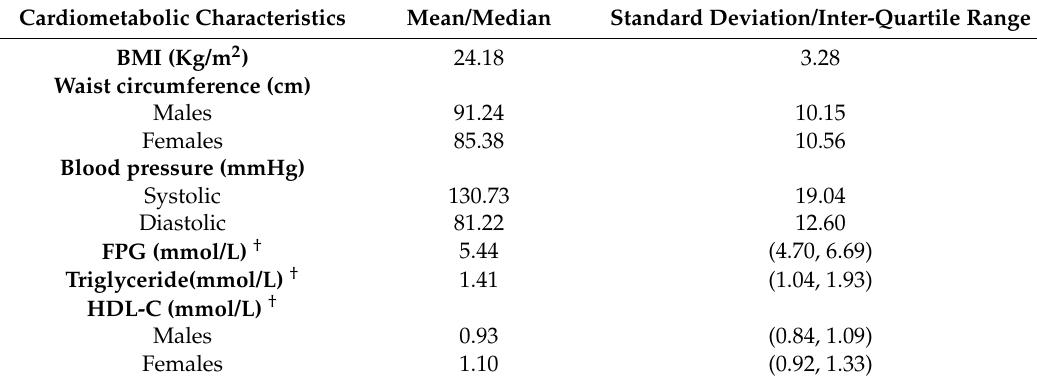
Table 2. Participants‘Cardiometabolic Characteristics (n = 204). Cardiometabolic